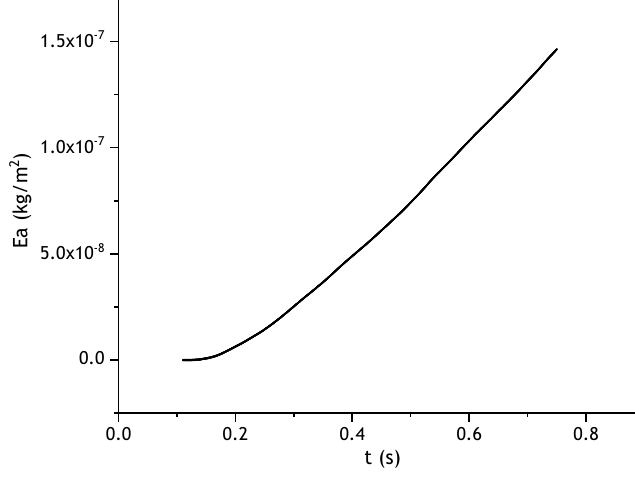
Figure 10. Change of average wear E a with time.